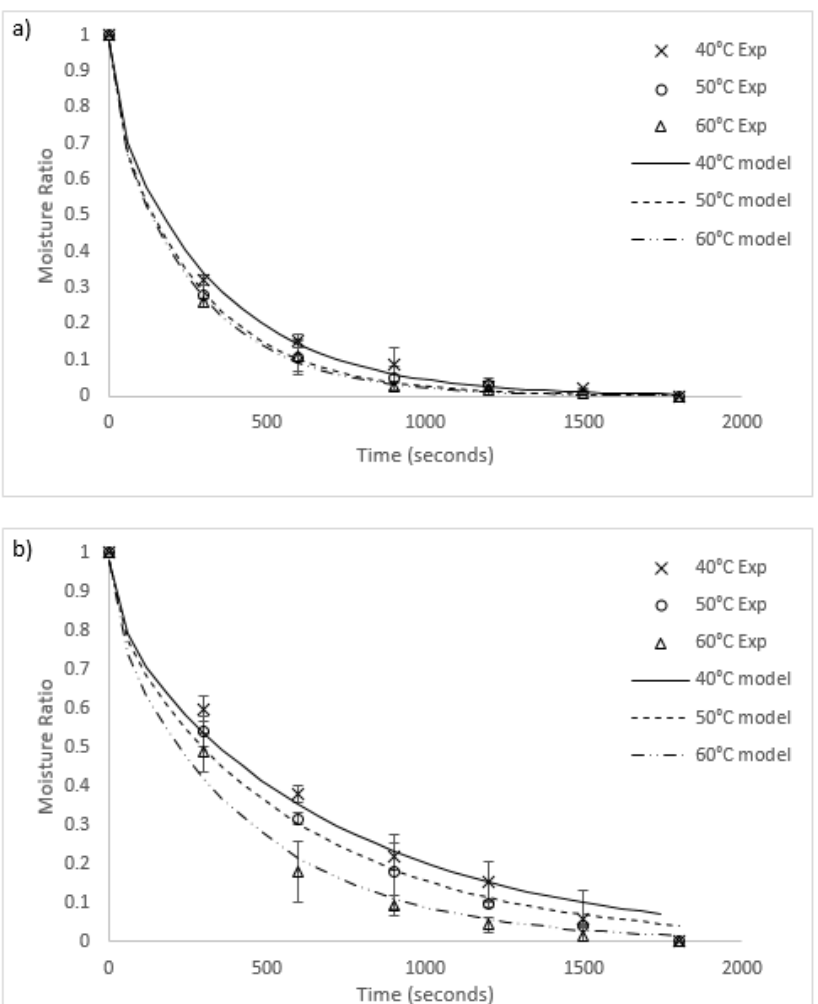
Figure 4. Comparison of convection drying results and models for ( a ) U. ohnoi and ( b ) O. intermedium (Exp = experimental; model = modelling outcome).